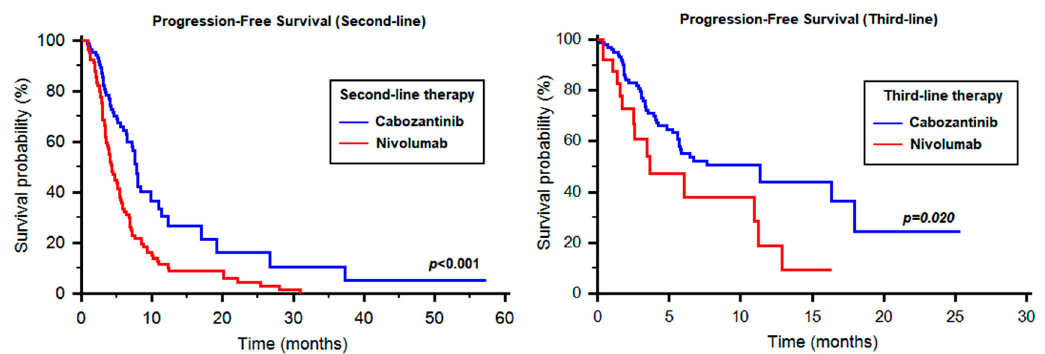
Figure 4. Comparison between cabozantinib and nivolumab in the second- and third-line setting.